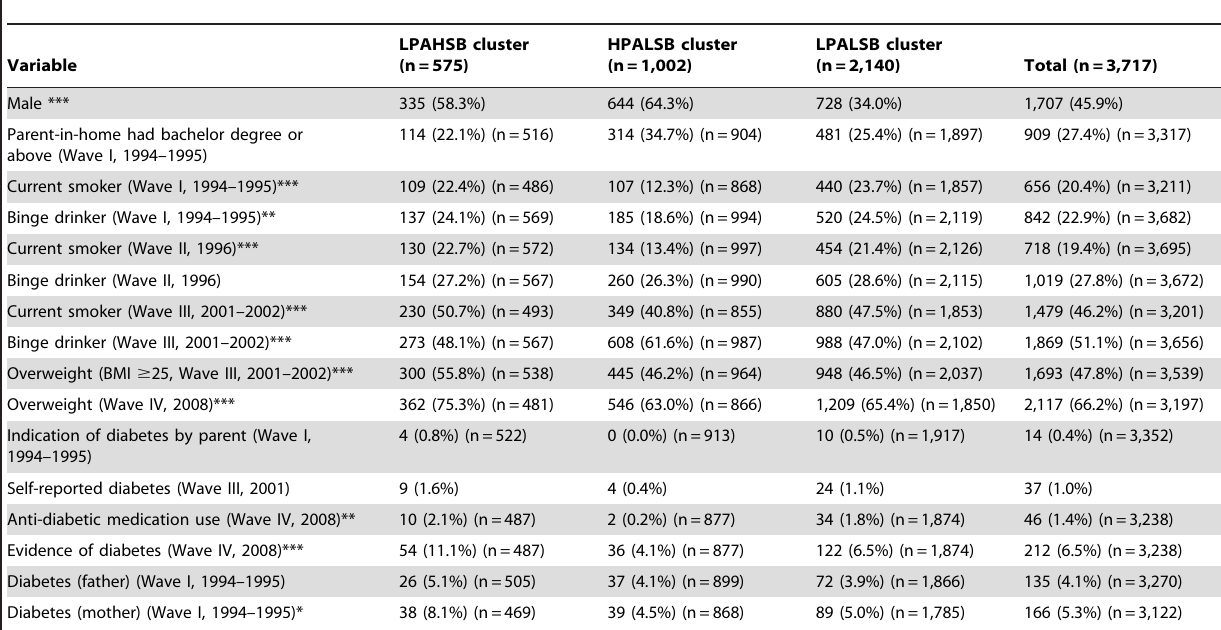
Table 4. Characteristics of the three clusters and the total sample (categorical